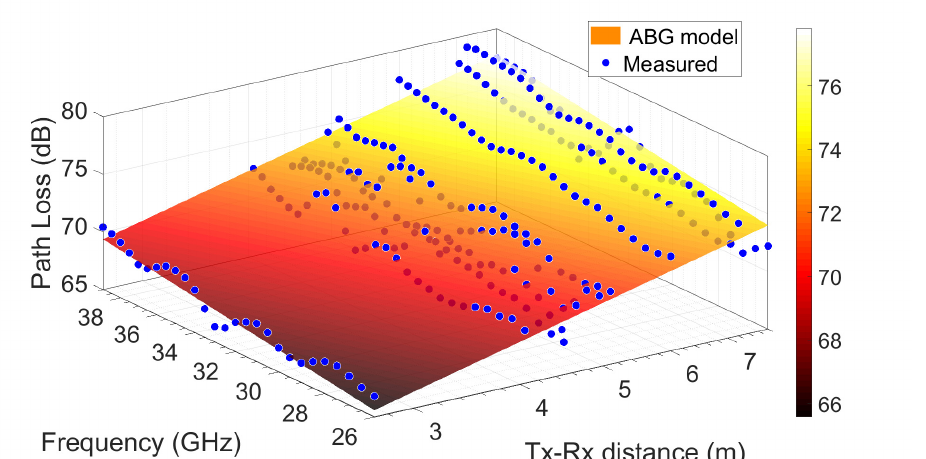
Figure 11. Measured and ABG path loss model in LOS conditions.